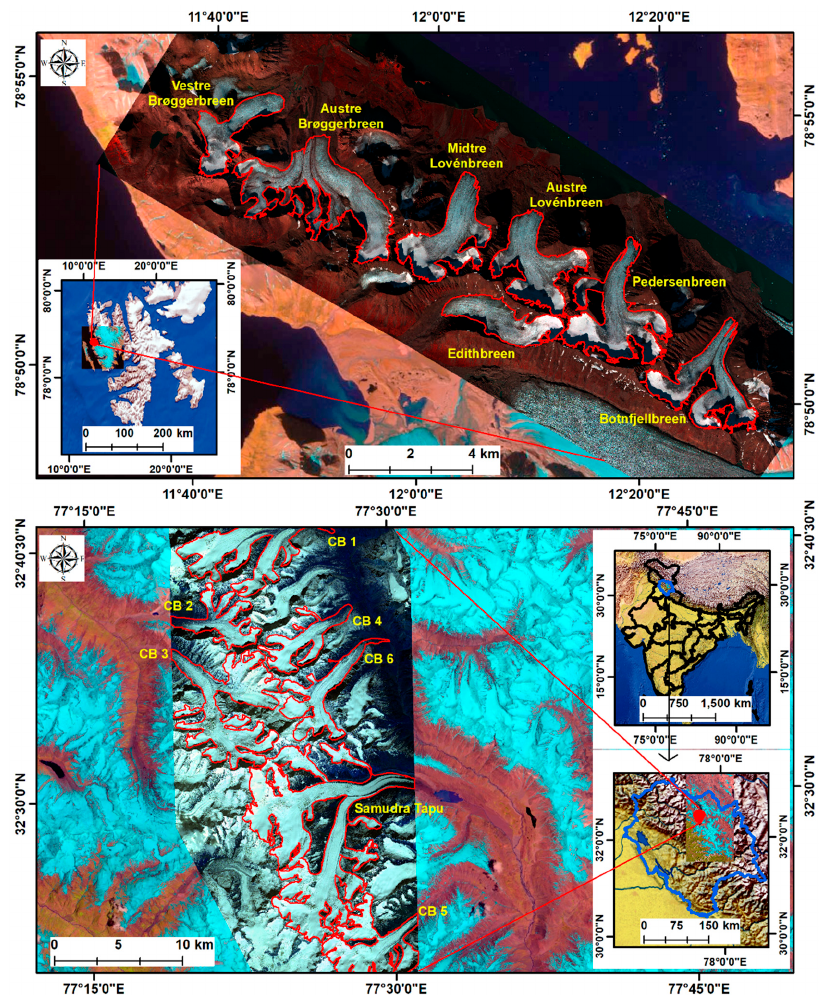
Figure 1. Geographic location of the selected glaciers and the local geomorphology. The VHR WorldView-2/3 imagery is imposed upon Sentinel 2A (10 m) imagery (Himalaya: Copernicus Sentinel data 2021, processed by ESA; Svalbard: Copernicus Sentinel data 2022, processed by ESA). WorldView-2/3 was obtained from Digital Globe, Inc., Westminster, CO, USA. Chandra–Bhaga Basin image: WorldView-2 © 2014 Maxar; Ny-Ålesund image: WorldView-3 © 2016 Maxar. Band display combination: Red—Band 2, Green—Band 3, Blue—Band 2. Inset maps outlining Himachal Pradesh, India, and Svalbard were prepared using Natural Earth (Free vector and raster map data @ naturalearthdata.com). The projection and datum of the Svalbard image are WGS 1984 UTM Zone 33N, and the Himalayan image are WGS 1984 UTM Zone 43N. Elevation data consisted of 30 m Advanced Spaceborne Thermal Emission and Reflection Radiometer (ASTER) and Global Digital Elevation Model (GDEM) v2 [43] for the Chandra–Bhaga Basin, and 5 m Arctic DEM [44,45] for Ny-Ålesund.